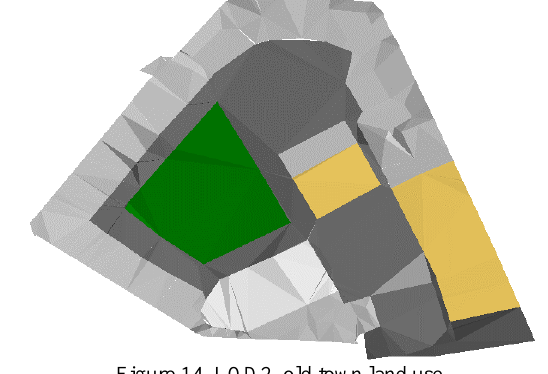
Figure 14. LOD2, old town land use